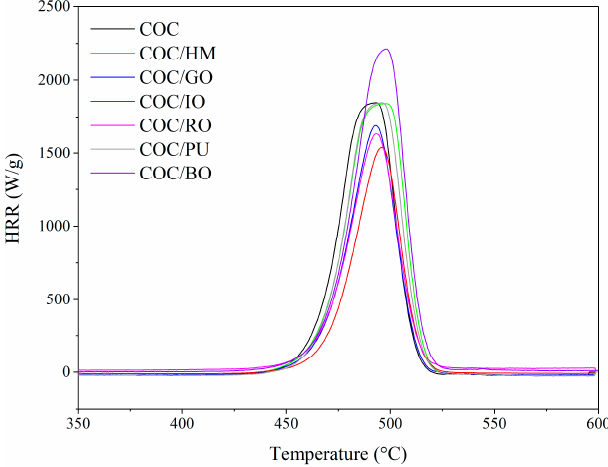
Table 4. Microscale combustion calorimetry analysis data.